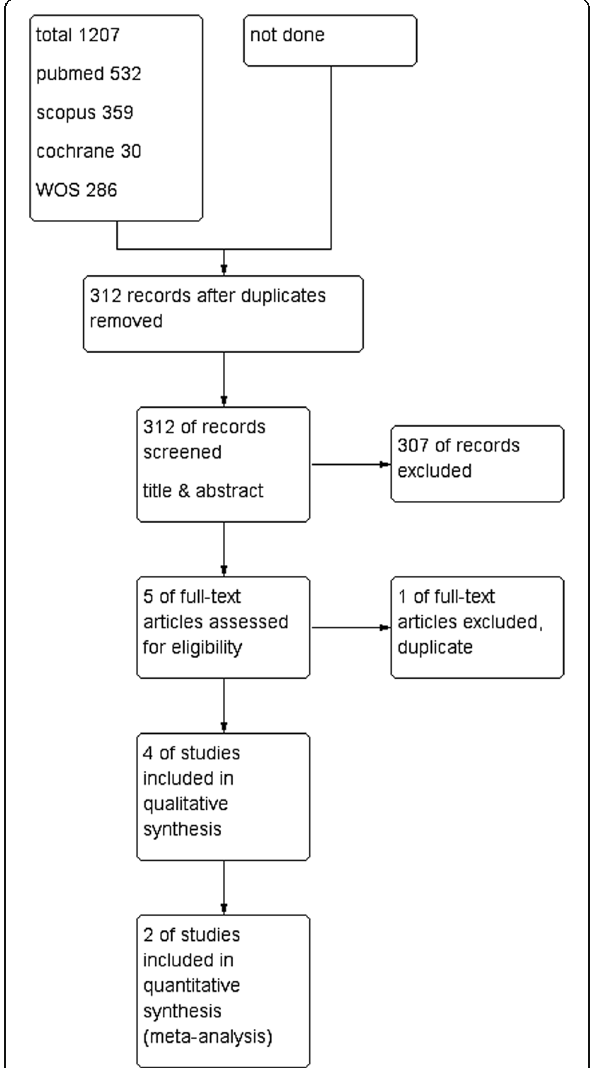
Fig. 1 Prisma flowchart for studies